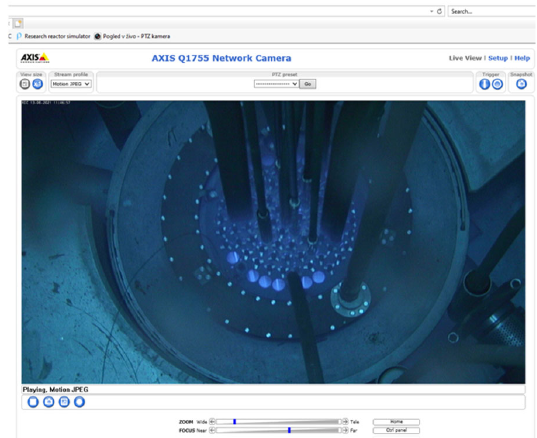
Figure 7 Cherenkov radiation is visible on the remote camera mounted above the reactor core. Students could view this camera at any time and use the zoom